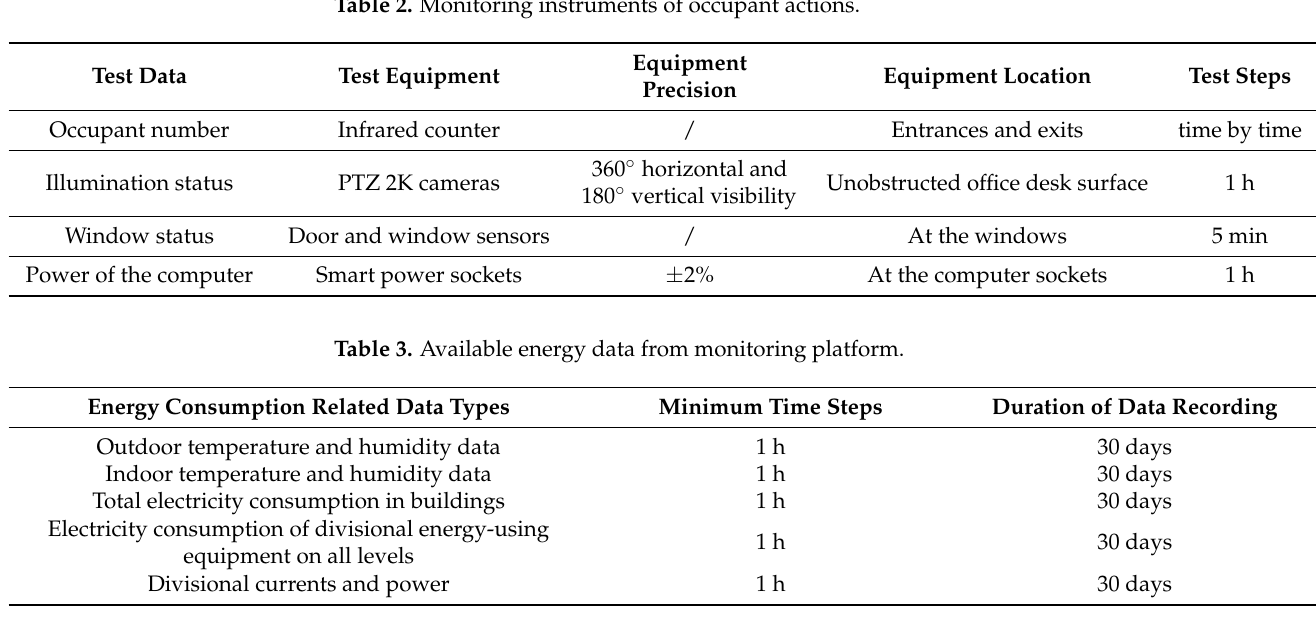
Table 2. Monitoring instruments of occupant actions.